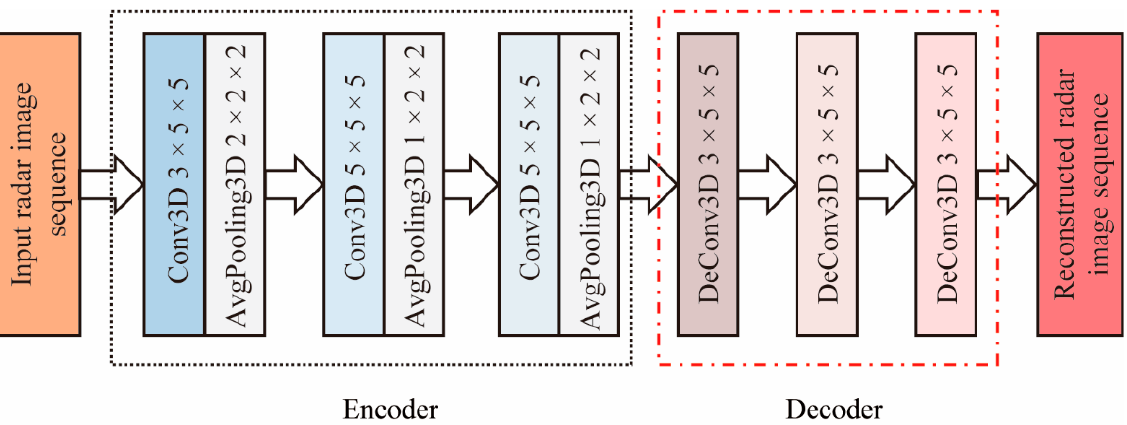
Figure 3. Network architecture of the three-dimensional convolutional neural network (3DCNN) model.